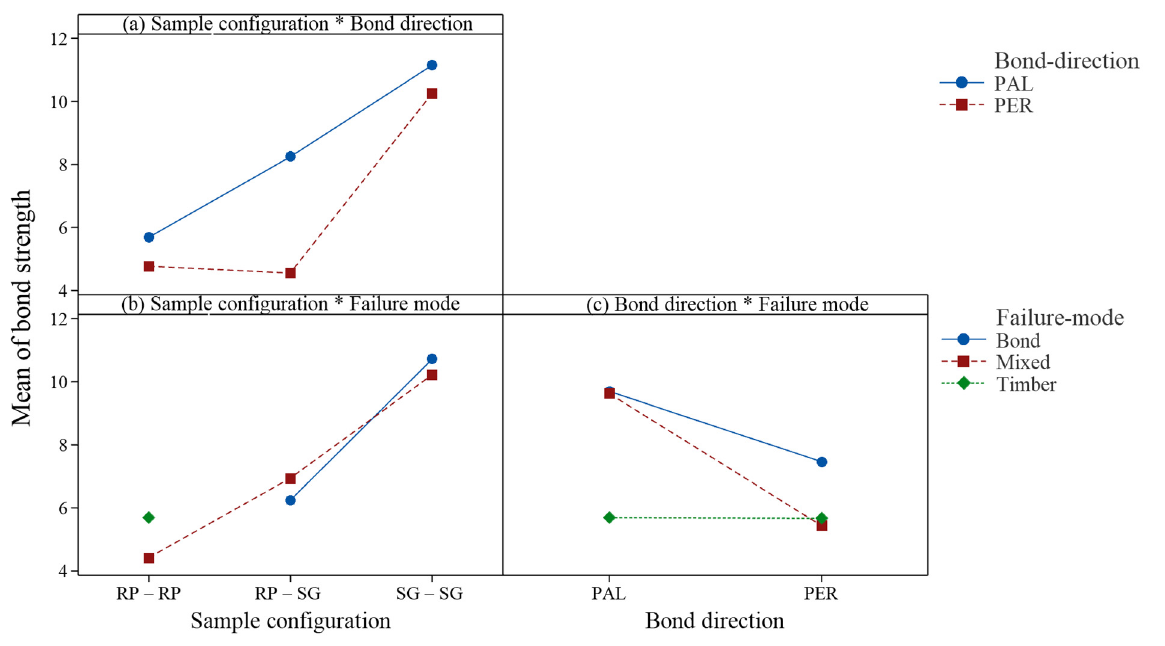
Figure 10. Interaction plot between sample configuration, bond direction and failure mode on bond strength.